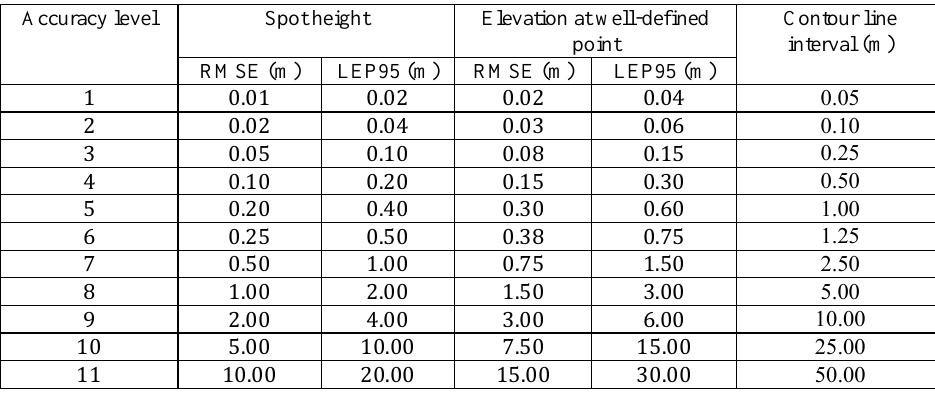
Table 2: Accuracy levels for mapping (vertical)